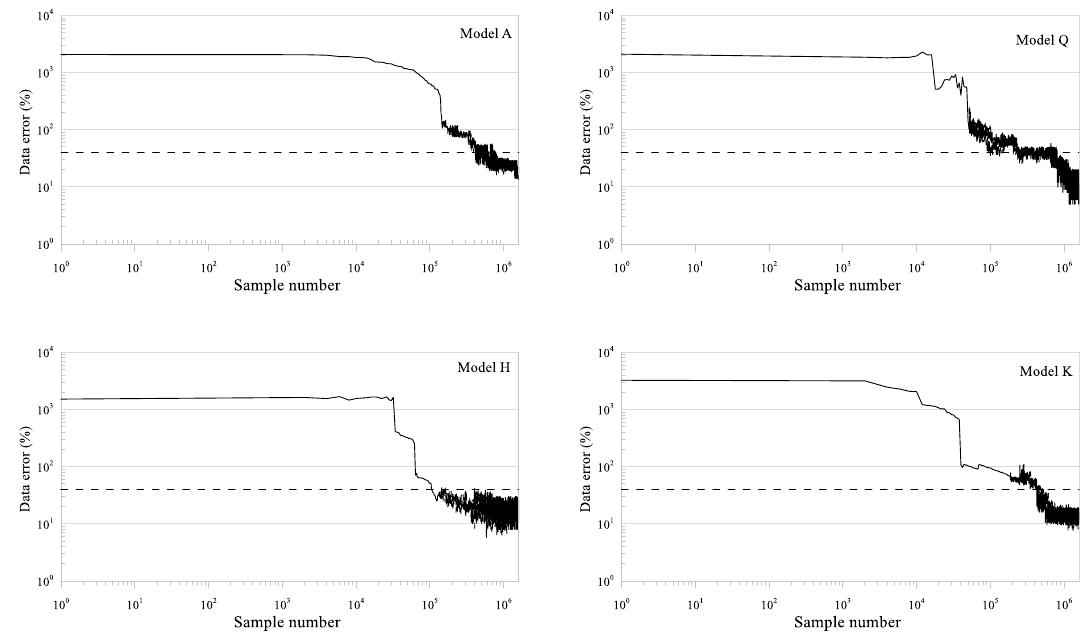
Fig. 4 Date error curves of MCMC inversion results for 3-layer models. The total sample number is 1600000. The black dotted line is data error = 40%, which is the threshold of end burn-in period